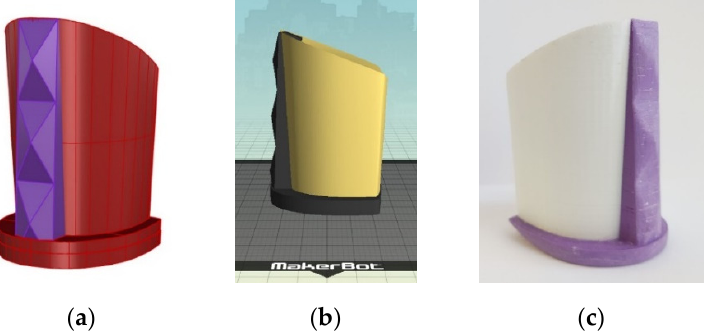
Figure 9. Making of the heel prototype: ( a ) CAD model; ( b ) positioning on the 3D printer working surface; ( c ) 3D printed ABS prototype.